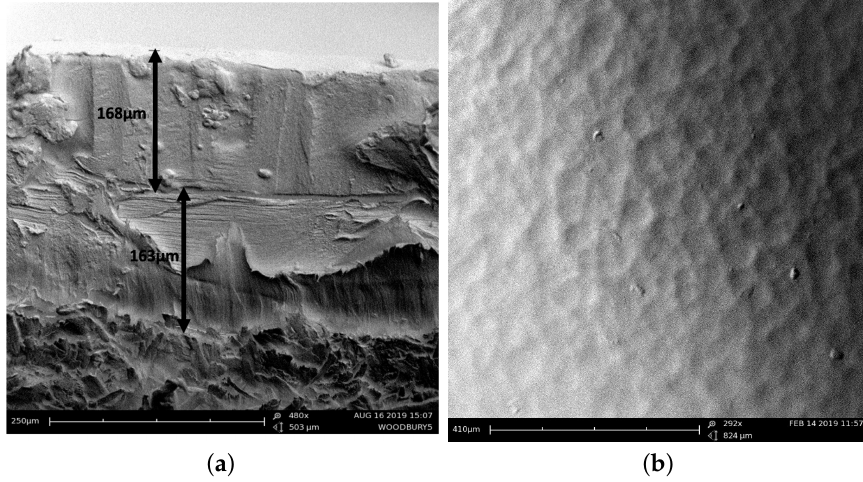
Figure 5. ( a ) SEM image of the cross section in a double-layer red print, ordered as MY, showing two well-defined print layers are of similar height. This is due to the built-in accommodation provided by the second-layer printing plate, as described in the text. ( b ) Image of the paper surface, showing the uneven substrate. The feature size, averaged over fifteen measures, is 61 µ m in diameter. This could be one of the immediate causes for variation in print height across a flat plane of